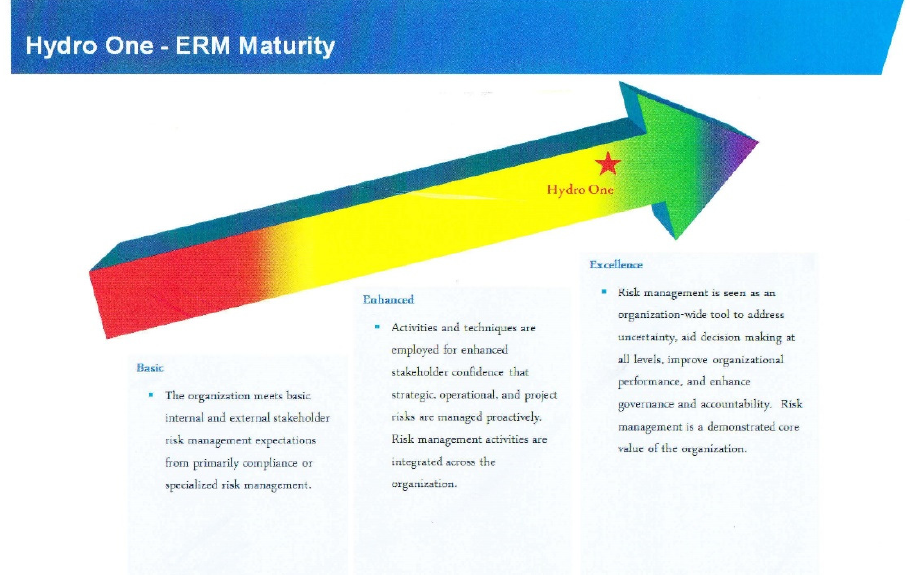
Figure 2. KPMG’s graphic assessment of Hydro One’s ERM processes in their Report of 2012.